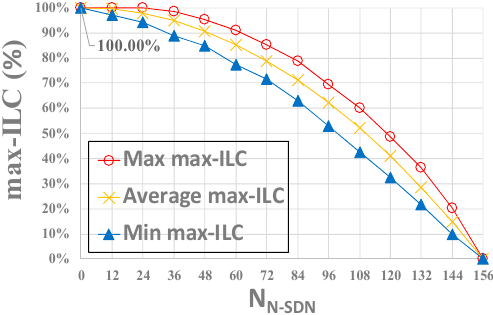
Figure 6. The influence of different numbers of N ‐ SDN nodes on max ‐ ILC.